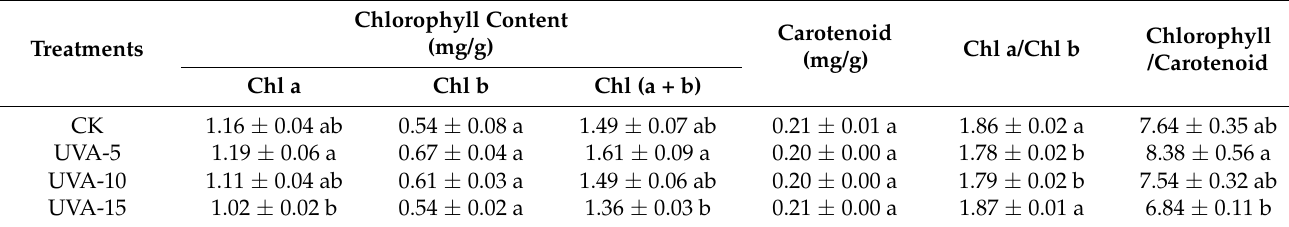
Table 1. Photosynthesis pigments of Chinese kale baby-leaves under different supplemental UV-A intensity. Treatments